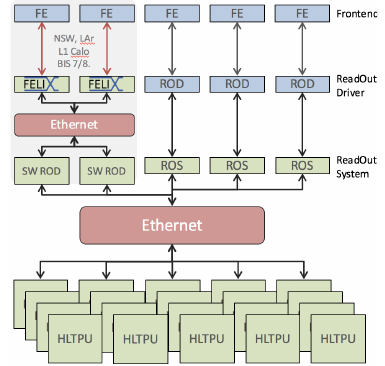
Figure 1. Diagram of the ATLAS DAQ System in Run 3. The new FELIX and SW ROD Components (left) operate alongside the legacy (ROD and ROS) system on the right. HLT processing units (HLTPUs) are able to sample event data from both readout paths via an identical